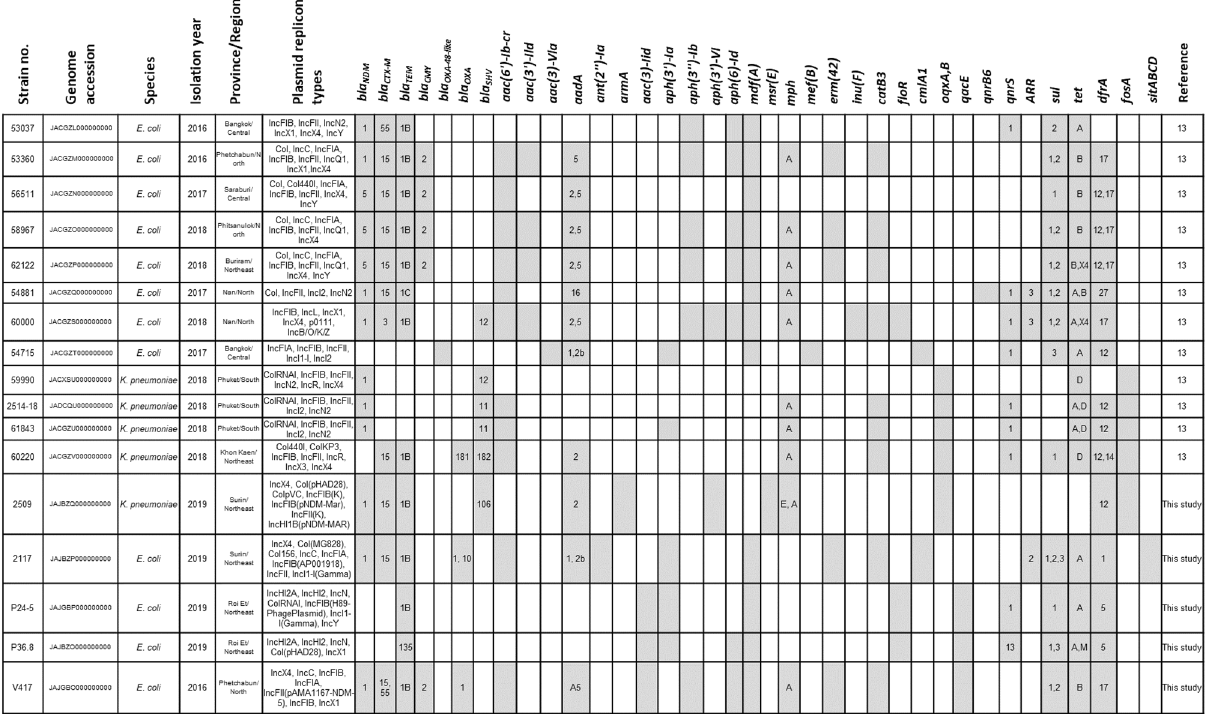
ST336 (1/11; 9.1%), and ST340 (1/11; 9.1%). IncI2 was harbored in ST3052 (1/4;25%), ST1287 (1/4;25%) in E. coli and in K. pneumoniae ST336 (2/4; 50%), whereas IncHI/IncN were carried by E. coli ST6721 (1/2; 50%) and the new ST (1/2; 50%) . Figure 6 demonstrated diversity in the upstream and downstream coding sequences flanking mcr-1 in each type of plasmid. The IncHI2/IncN carrying mcr-1 plasmids showed the repressor gene TnpA and the conjuga- tive transfer gene TraN upstream and the tellurium resistance genes downstream of mcr-1 . The IncI2 carrying mcr-1 plasmids revealed the same integrase gene downstream but different genes upstream. In contrast with 11 IncX4-carrying plasmids, the flanking coding sequences or genes were similar in 9 plasmids containing the gene RepB family plasmid initiator replication protein upstream (nos. 2117, 2509, 58967, 62122, 59990, 60220) and downstream (nos. 53037, 53060, 60000) or peptidyl-arginine deaminase downstream, whereas 2 IncX4 plasmids (V417 and 56511) had different genes upstream and downstream of mcr-1 (Fig. 6). Isolates with nos. 2117, 2509, 62122, and 60220 showed high genetic organization similarity in the plasmids (Figs. 5 and 6). Among the mcr-1 - harboring plasmids, other antimicrobial-resistant genes ( bla TEM-135 or bla TEM-1B ) than mcr-1 were detected in IncHI2/IncN (P24-5 and P36.8) that are first reported in this study. All IncX4 and IncI2 plasmids contained only mcr-1 ; no other antimicrobial resistant genes were detected. As shown in Fig. 7, plasmid phylogeny demonstrated diversity among the mcr-1 harboring-plasmids. Most IncX4 carrying mcr-1 plasmid were grouped in three clusters. The first cluster comprised strain 59990 which was related to the pTB602 plasmid of Salmonella sp. SSDFZ69 from China (NZ_CP034833.1). The second cluster contained strains 58967, 50220, 2509, 62122, and 2117 that related to the plasmids pKPNH54.3 (NZ_CP024919.1) of K. pneumoniae NH54, and PN42 (MG557854.1) of E. coli PN42, both from Thailand. The third cluster con- sisted of 53360 and 53037 which related to the plasmid pEC931 (CP049122.1) of E. coli EC931 from China. We found that the other IncX4-type plasmids carrying mcr-1 of strains 56511, 60000, and V417 were not clustered and were located on different branches (Fig. 7). The IncHI2/IncN harboring mcr-1 plasmids of strains P24-5 and P36.8 were clustered together with plasmids pMCR_WCHEC050613 of E. coli and WCHEC050613 from China (NZ_CP019214.3). Among the IncI2 type plasmids harboring the mcr-1 , strain 54881 was related to the p1002-MCR-1 plasmid (NZ_CP021205.1) of E. coli Z1002 from China, whereas it was a distant relative from strains 2514-18, 61843, and 54715. However, strains 2514-18 and 1843 were grouped together with two plasmids (p5CRE51-MCR-1 of E. coli 5CRE51 from Taiwan (NZ_CP021176.1) and pMCR-H9 (NZ_CP029184.1) of E. coli H9Ecoli from China).